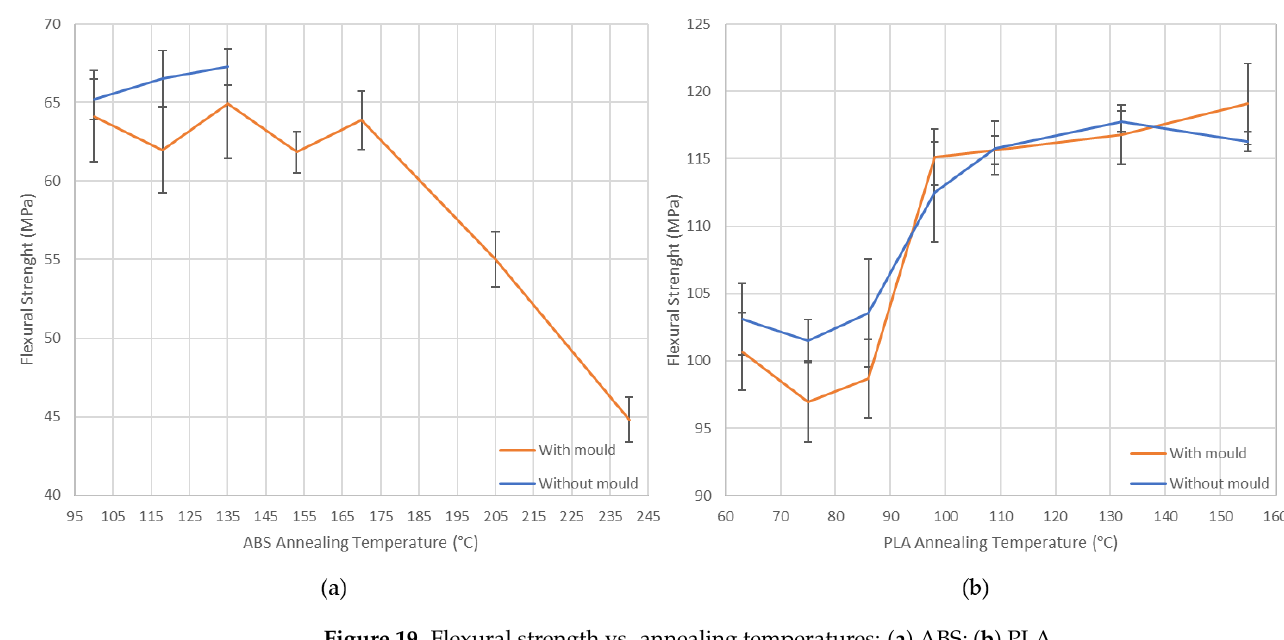
Figure 19. Flexural strength vs. annealing temperatures: ( a ) ABS; ( b ) PLA.